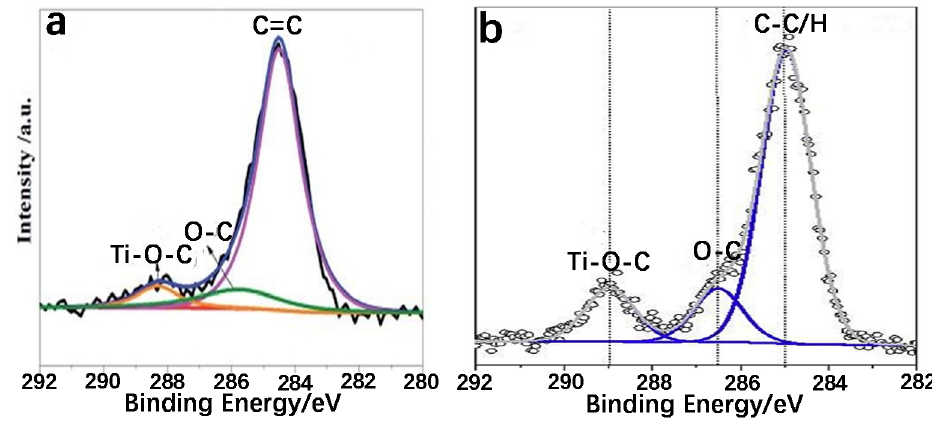
Figure 1. The existence of the Ti–O–C bond in XPS spectra of C1s ( a ) [54] and ( b ) [55].